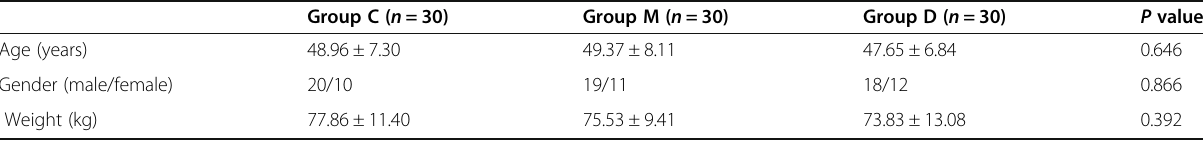
Table 3 Demographic profile of the study groups expressed as mean ± SD or number of